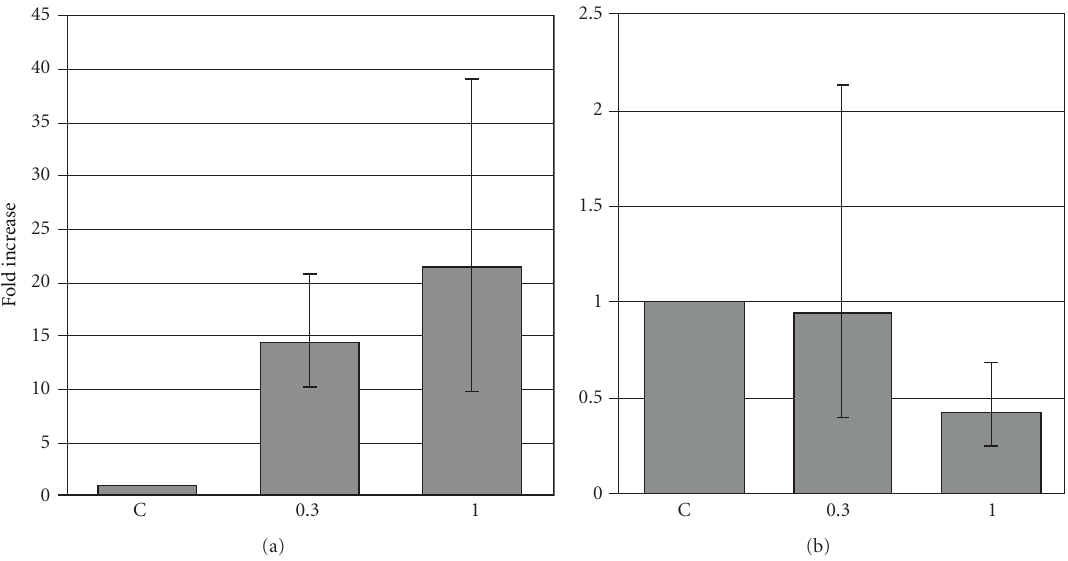
Figure 2: The e ff ect of 0.3% and 1% DMSO on the transcriptional activity of tyrosinase gene in A-375 cells cultured by 3 (a) or 7 (b) days. Each bar represents the mean ± SE; Control value was taken as 1; ∗ P < 0 . 05.